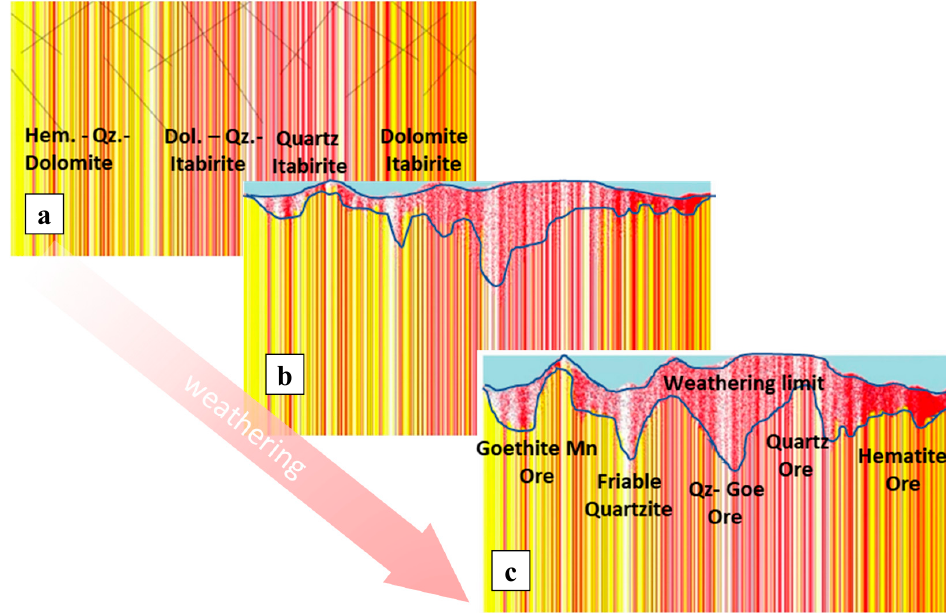
Figure 17. Leaching simulation in a 2D original vertical banded matrix, with hematite in red, quartz in white and carbonate in yellow ( a ). Intermediate leaching of carbonate ( b ) and final leaching step ( c ), with the blue area highlighting the collapsed surface.